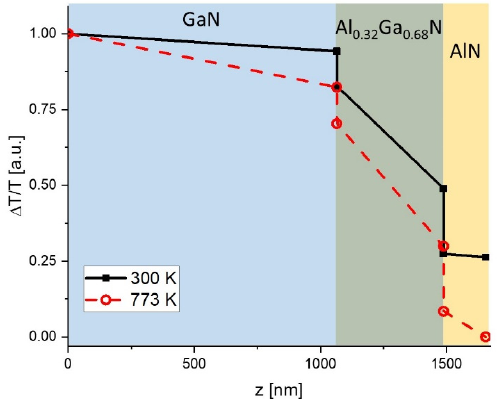
Figure 4. The normalized temperature profile of the HEMT structure: Starting with the GaN, which is underneath the heat source of the HEMT. The solid black line shows the temperature profile at 300 K, while the dashed red line at 773 K.